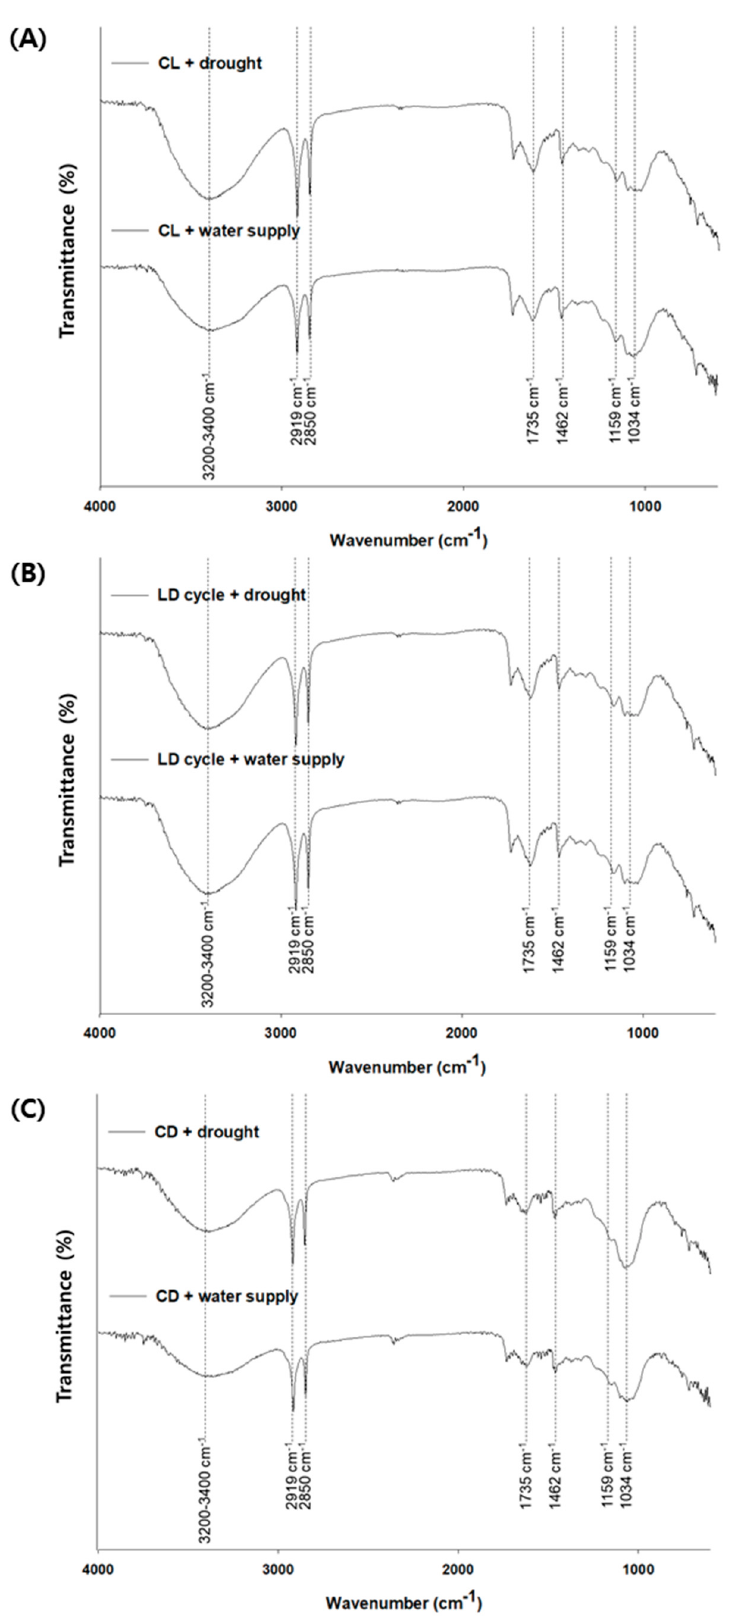
Figure 6. Fourier transform infrared spectra of adaxial surface of Ardisia japonica leaf under ( A ) CL (continuous light), ( B ) LD cycle (light/dark cycle; 14 h/10 h), and ( C ) CD (continuous dark) with drought and with water supply.